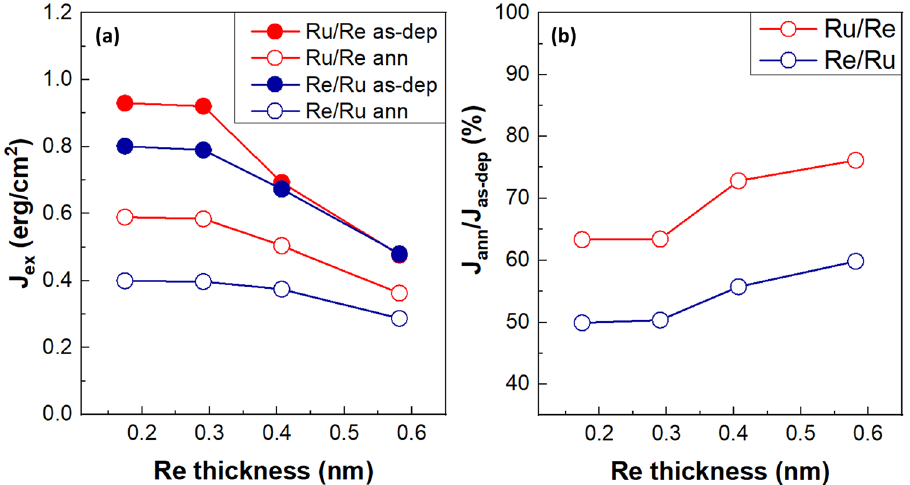
Figure 3. Effects of Re insertion on RKKY interlayer coupling. ( a ) Variations of J ex with Re thickness. The total thickness of the spacer is fixed at 0.79 nm. Red and blue lines represent the Re upper (Ru/Re) and lower (Re/Ru) insertion, respectively. Solid and open circles represent for as-deposited and annealed states, respectively. ( b ) J ann /J as-dep presents J ex changes after annealing of Ru/Re (red) and Re/Ru(blue) spacer.